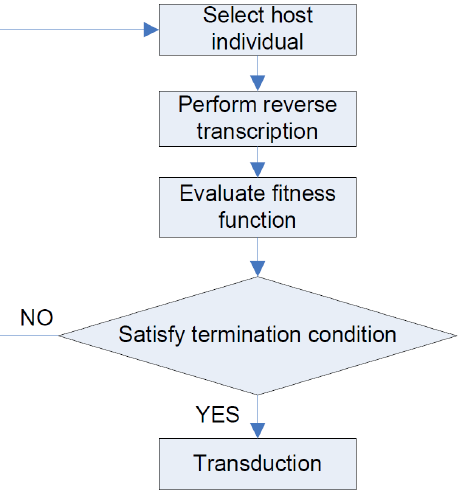
Figure 2. The procedure of viral infection in the virus−evolutionary genetic algorithm.